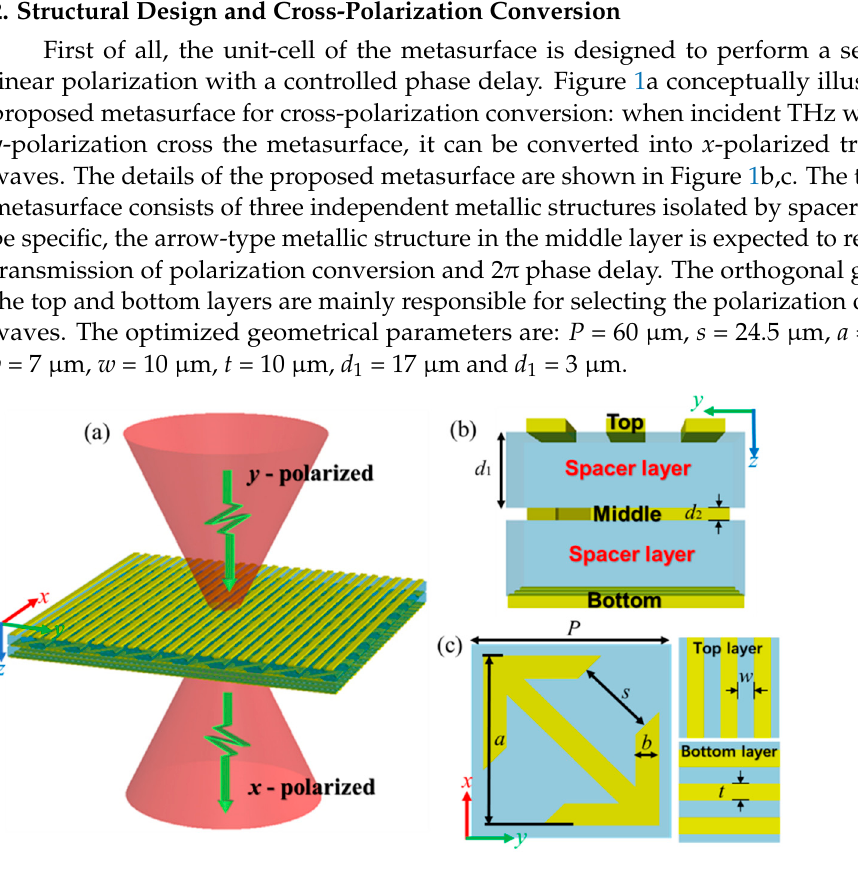
Figure 1. ( a ) Illustration of the polarization conversion metasurface. ( b ) The side view of the unit cell at y ‐ z plane. ( c ) The view of the layer at x ‐ y plane.